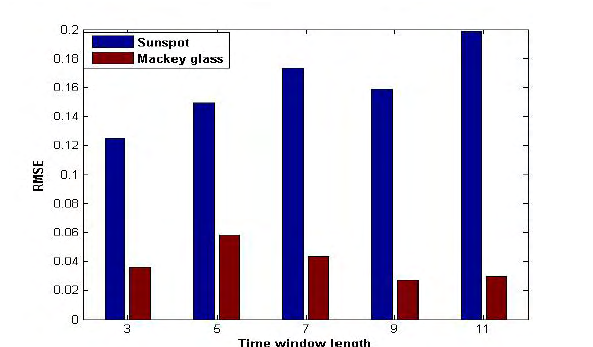
Fig. 5. The effect of window size